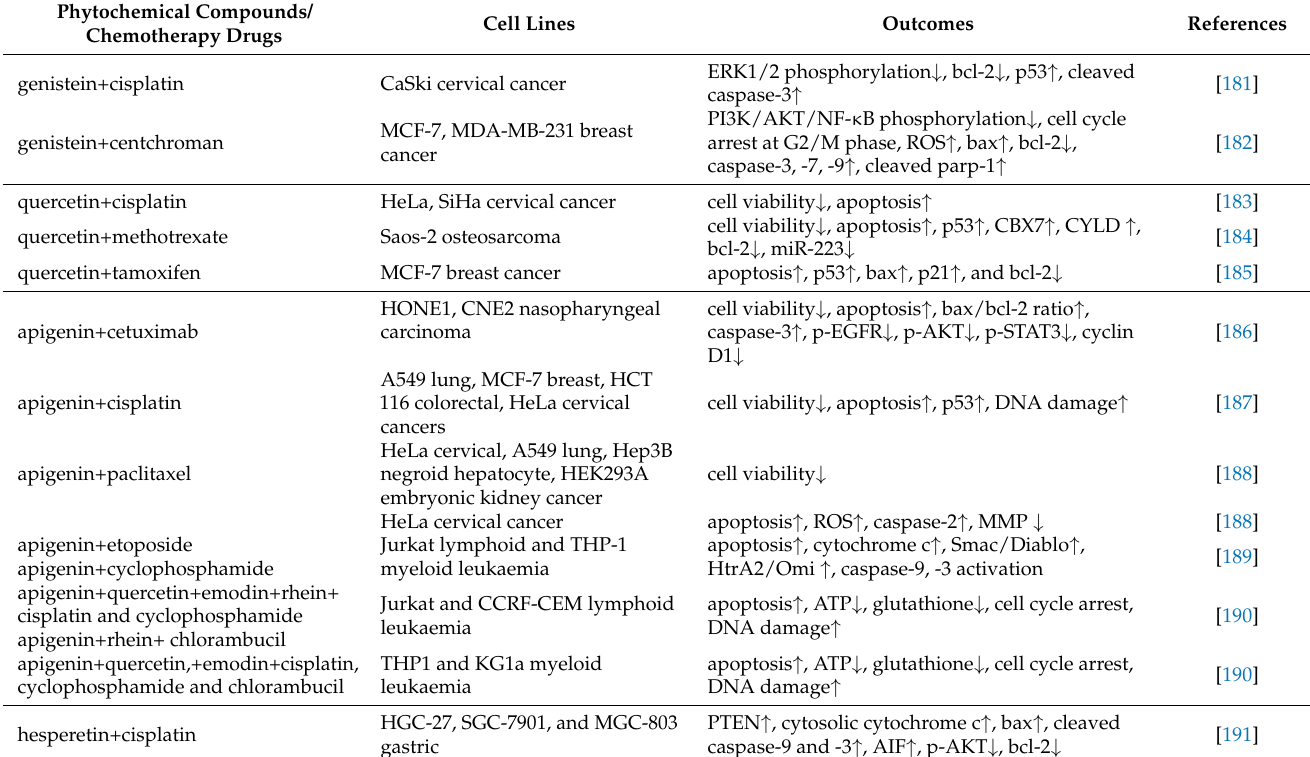
Table 2. Anti-cancer effects of the dietary polyphenol and/or chemotherapy drug